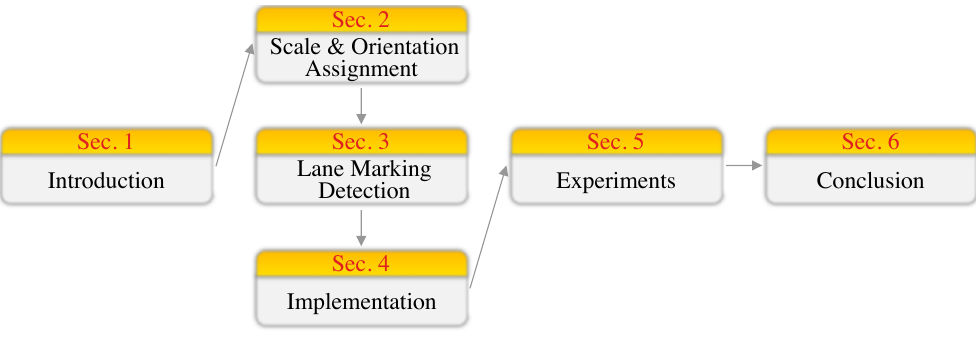
Figure 2. Introductory